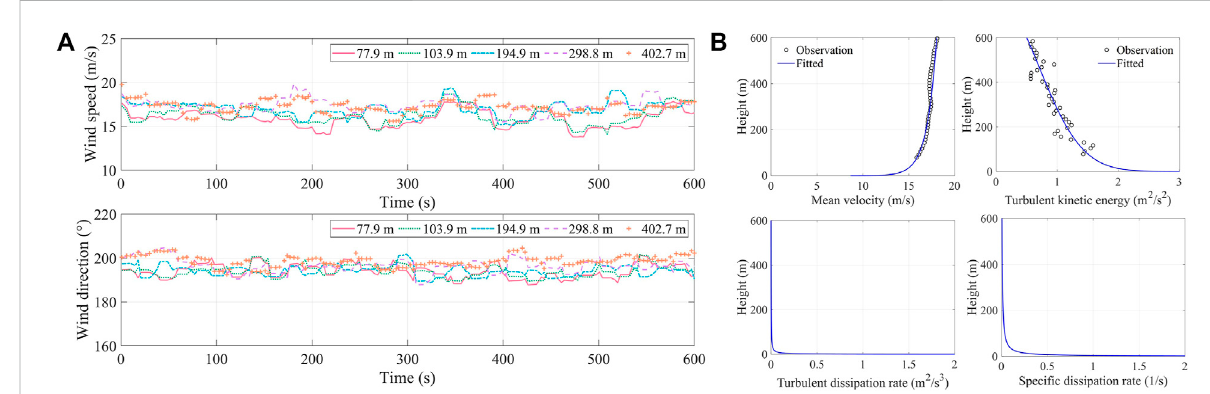
FIGURE 11 (A) Timehistoriesofwindspeed(unit:m/s)andwinddirection(unit: ° )fromdataset230measuredbyDWLat fi veheights,andthehorizontalaxis is time in seconds; (B) Velocity input at fl ow inlet in CFD simulations, including mean speed pro fi le (unit: m/s), turbulent kinetic energy pro fi le (unit: m 2 /s 2 ), turbulent dissipation rate pro fi le (unit: m 2 /s 3 ), and speci fi c dissipation rate (unit: 1/s).